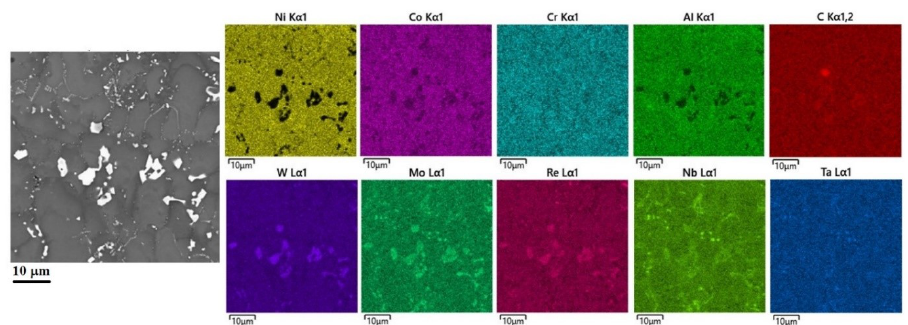
Figure 11. Distribution of elements in modes with low heat input (strategy 3, 200 W).